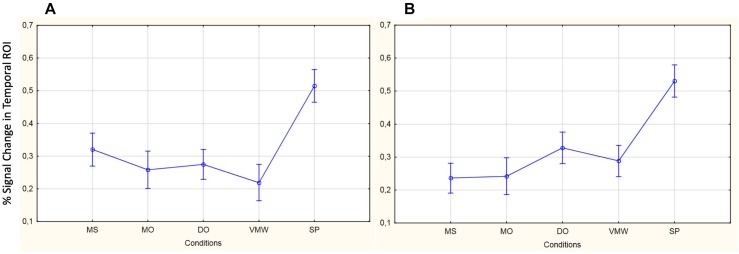
Percentage of signal change (%SC) in the temporal ROI including superior and middle temporal gyri, across the five experimental conditions (MS, MO, DO, VMW, and SP). (A) Left temporal ROI. (B) Right temporal ROI.